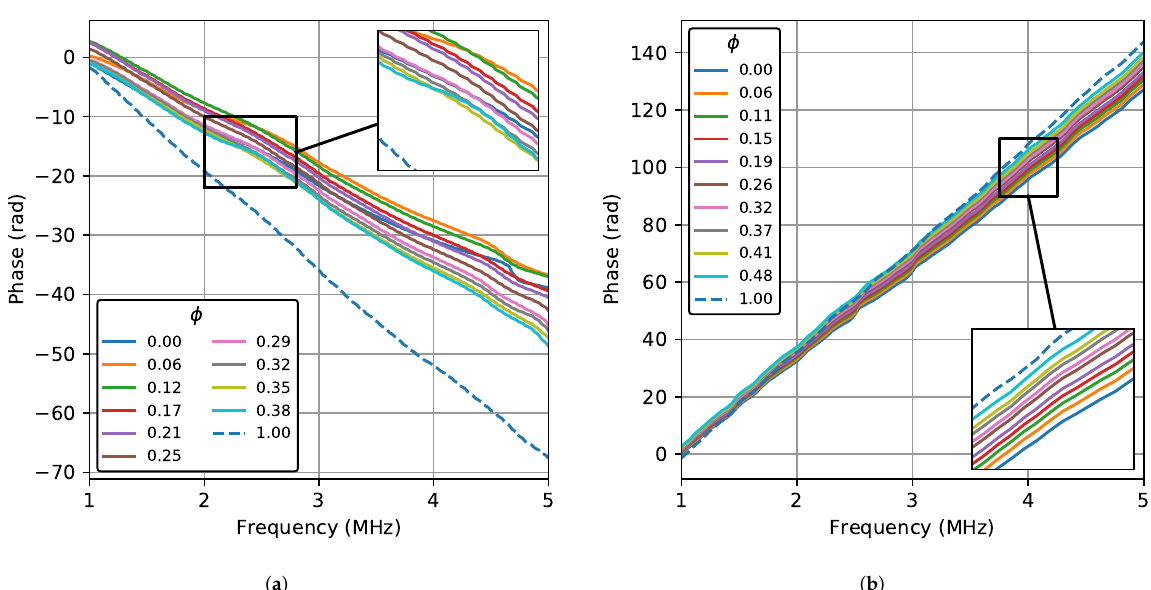
Figure 3. Phase of the Fourier transform as a function of frequency for all the water concentrations at 20 ◦ C in the transmission–reception (TRD) and backscattering (BSD) cases. ( a ) TRD. ( b )